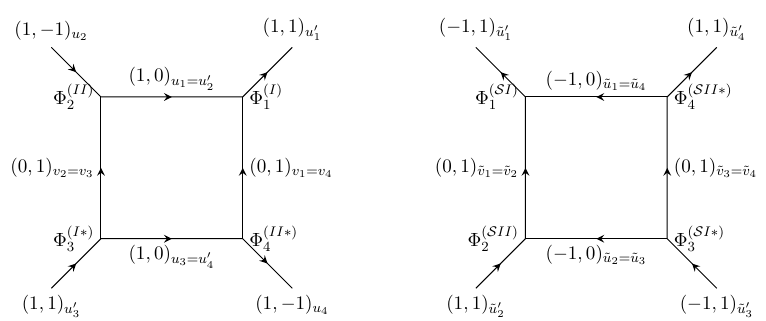
Figure 5 . Representation of the two dual U(2)